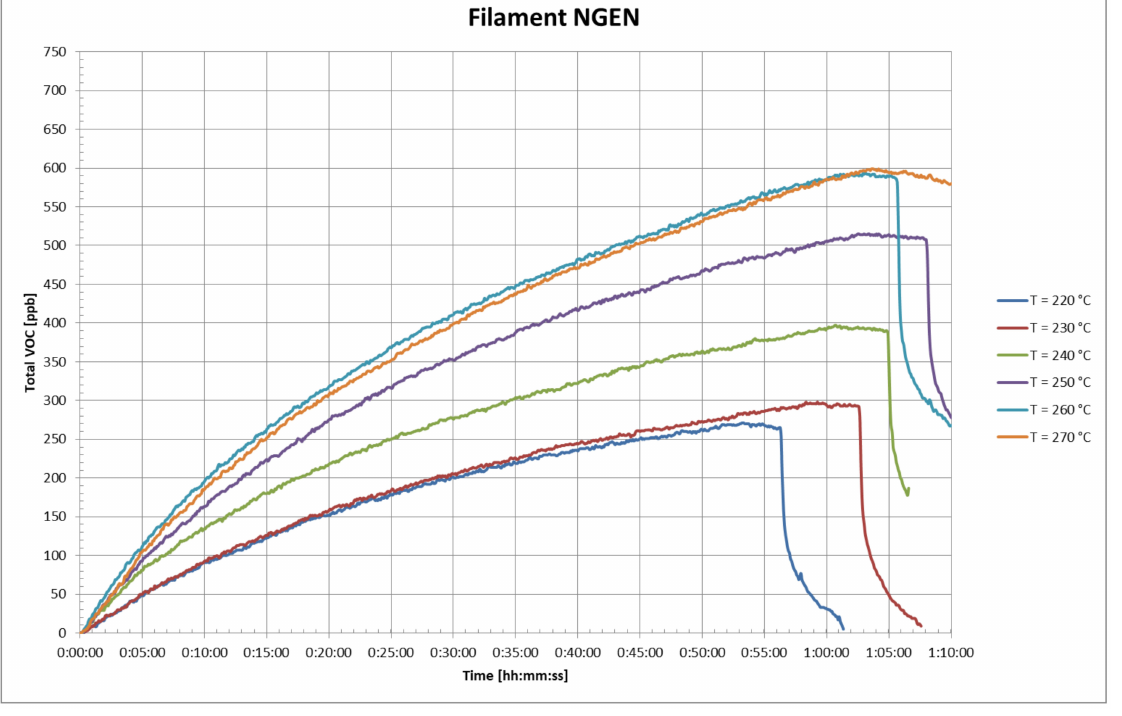
Figure 7. Total volatile organic compound (VOC) concentrations in the test chamber in the case of styrene free co-polyester (NGEN)